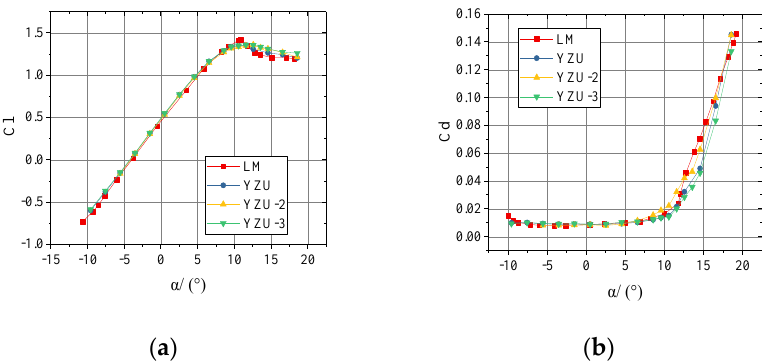
Figure 9. Comparison of experimental data of the DTU-LN221 airfoil (uniform inflow, Re: 1.5 × 10 6 ). ( a ) Lift coefficient comparison; ( b ) drag coefficient comparison.